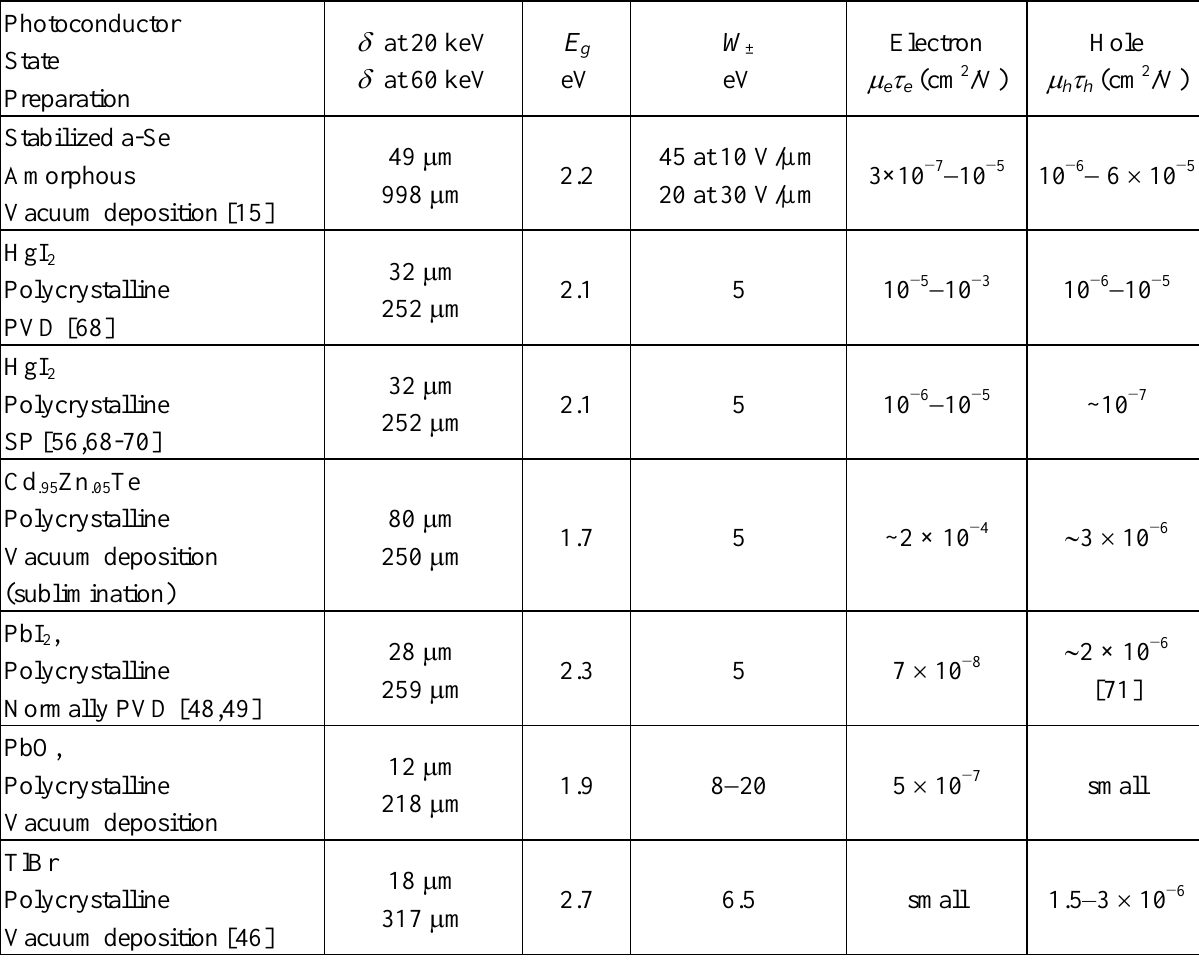
Table 1. Some typical or expected properties of selected x-ray photoconductors for large area applications.  is the attenuation depth at the shown photon energy, either 20 keV or 60 keV. From various references and combined selectively.  represents the carrier range. From various references including [14,16,67] and those listed in the table. (SP refers to screen printing, and PVD to physical vapor